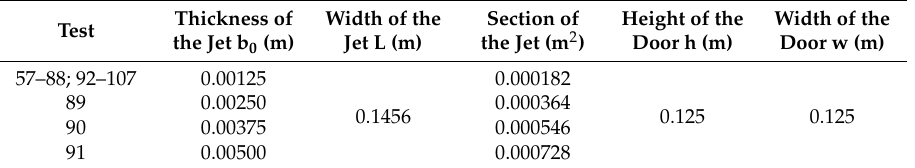
Table 1. Geometric characteristics of the jet.